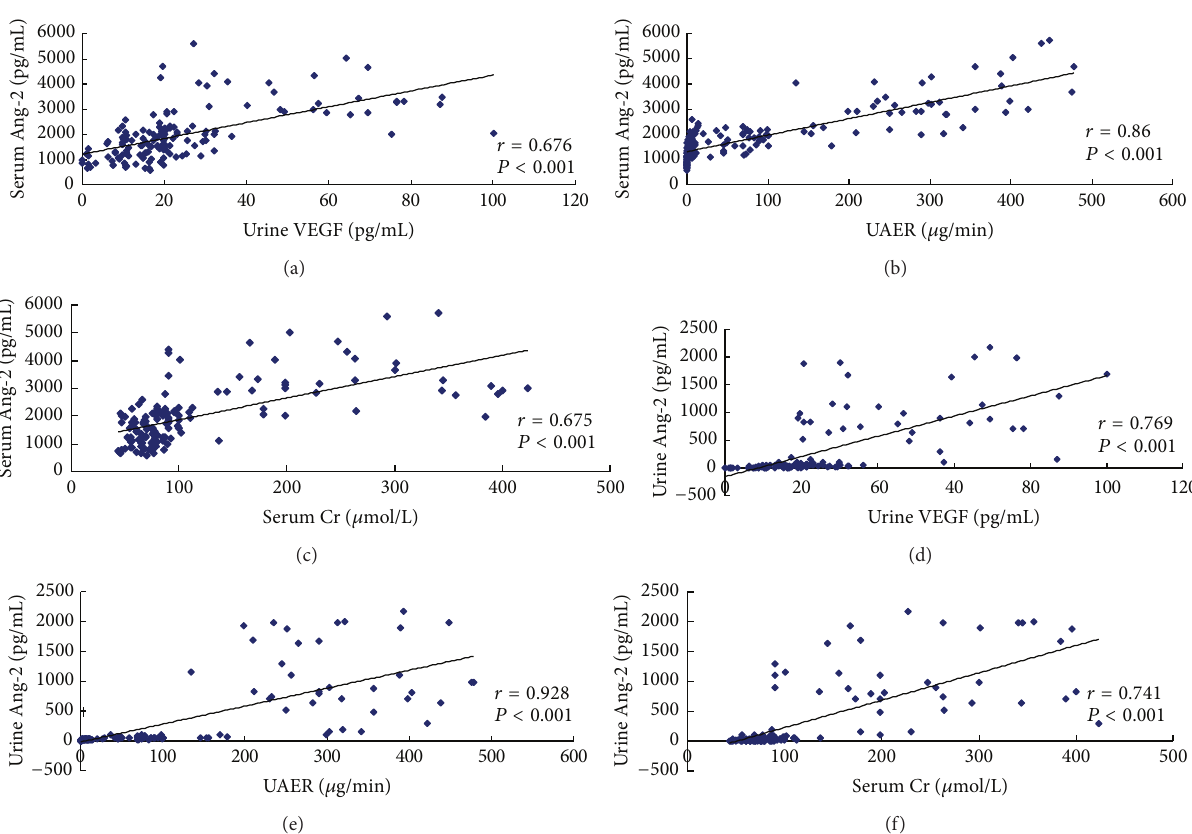
Figure 2: Correlation analysis for serum Ang-2 and urinary Ang-2 with urinary VEGF, UAER, and serum creatinine. Serum Ang-2 level correlated positively with urinary VEGF (a), UAER (b), and serum creatinine (c). Similarly, Urinary Ang-2 correlated positively with urinary VEGF (d), UAER (e), and serum creatinine (f). Ang-2: angiopoietin 2; VEGF: vascular endothelial growth factor; UAER: urinary albumin excretion rate; Cr: